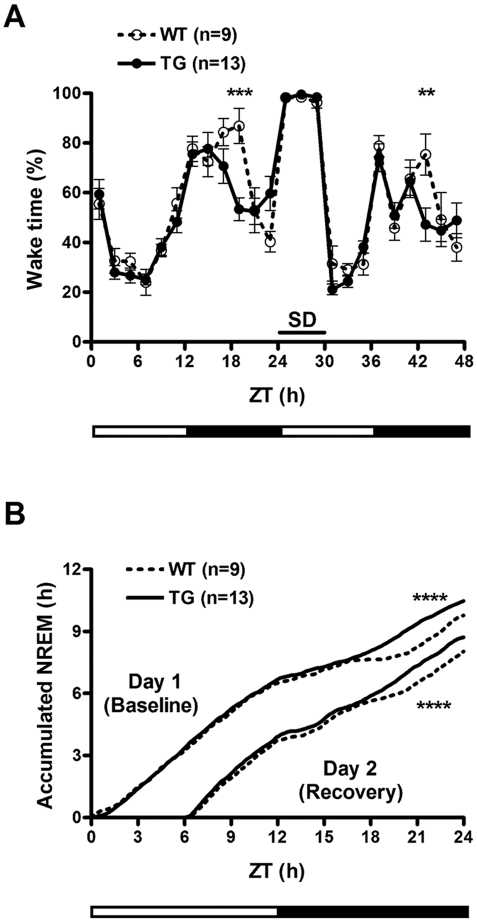
Decreased wakfeluness in human IGFBP3 transgenic mice.(A) Wakefulness is decreased in the second half of the dark/active period in human IGFBP3 transgenic mouse (hIGFBP3 TG) versus wild type littermates (WT). Reduced sleep rebound is also observed at the same Zeitgeber times (ZT) after sleep deprivation. (B) Cumulative NREM plots at baseline and during recovery after 6 hours of sleep deprivation. Note increased sleep in IGFBP3 transgenic mice in the second half of the active period, ZT17-24. **: p<0.01 versus WT; ***: p<0.001 versus WT. Temperature and locomotion were also affected, see Fig. S2.